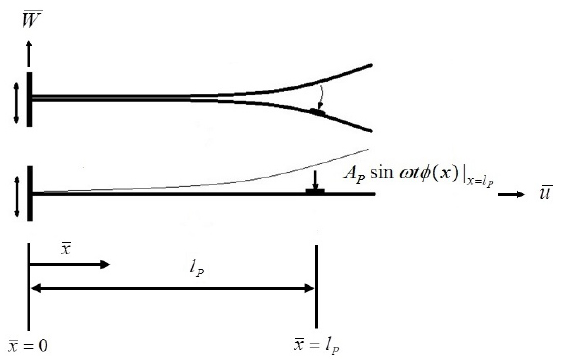
Figure 11. Schematic diagram of DESS system.